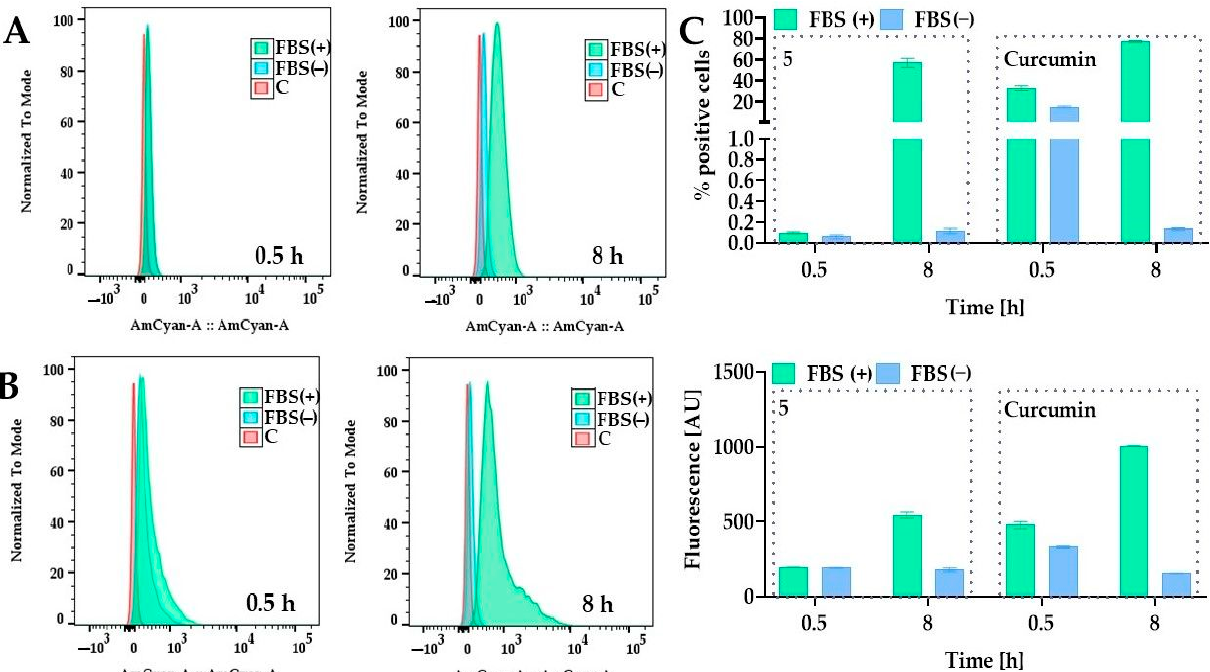
Figure 12. The influence of fetal bovine serum on curcumin and compound 5 uptake by 5637 cells. The uptake of compound 5 and curcumin was determined in a medium with FBS (10% v/v ) and a serum-deprived medium (0% FBS). Panel ( A ) presents the representative histograms for compound 5 and panel ( B ) for curcumin. Panel ( C ) presents the results as a percentage of positive cells and mean fluorescence intensity. Compound 5 and curcumin were added to the cells at a concentration of 10 µM and incubated for 0.5 h and 8 h under standard cell culture conditions. The DMSO was used as a control. The fluorescence was measured by flow cytometry after excitation with a 405 nm laser and detection with a 505.5–550.5 nm band-pass filter (528/45). Abbreviations: fetal bovine serum, FBS; control, C.